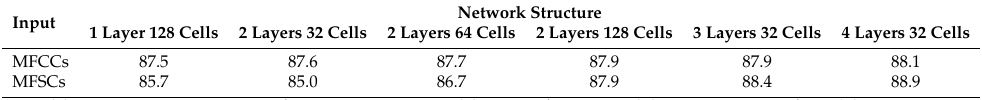
Table 3. Effect of MFSC features on the M 0 model’s performance (validation set). Input